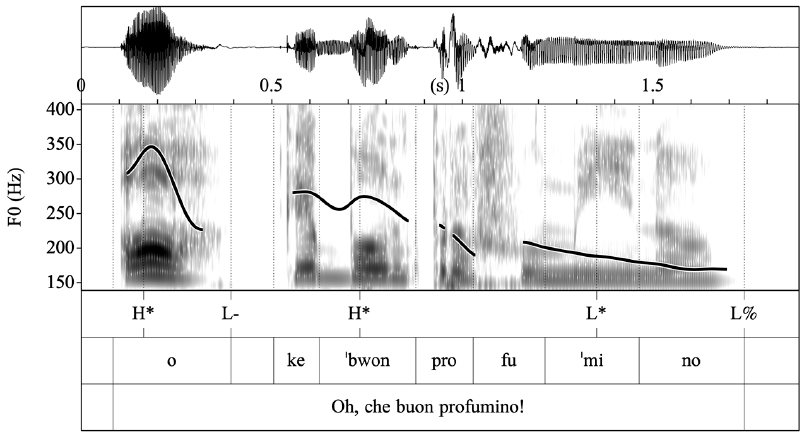
Figure 21 . Waveform, spectrogram and F0 trace of the what -exclamative Che buon profumino! in L2 Italian (F38, level C2) produced with L* L%.